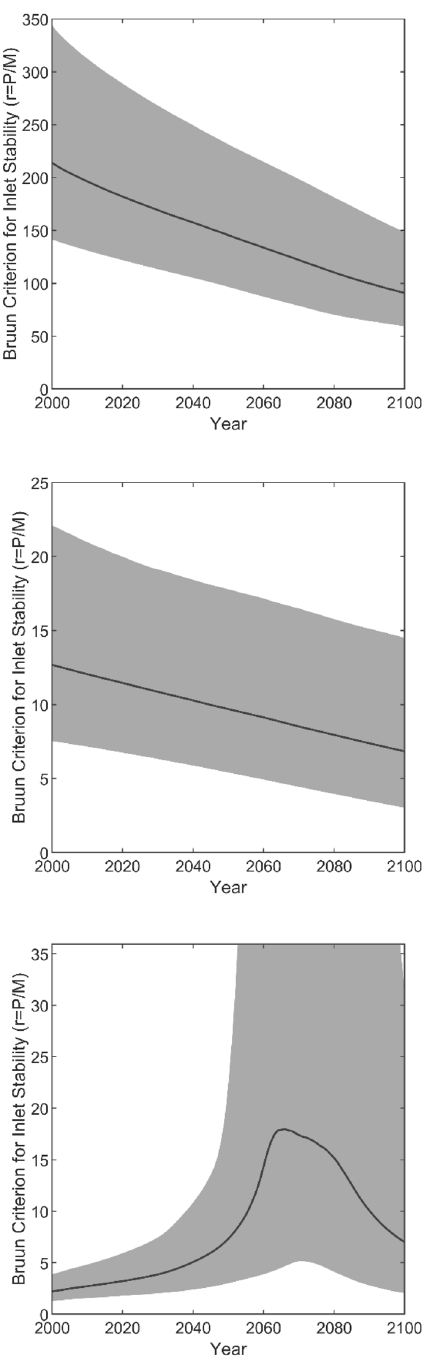
Figure 5. RAPSTA model results for Negombo lagoon (top), Kalutara lagoon (middle), and Maha Oya river (bottom). The solid line shows the median projection and shaded area shows the 95% confidence